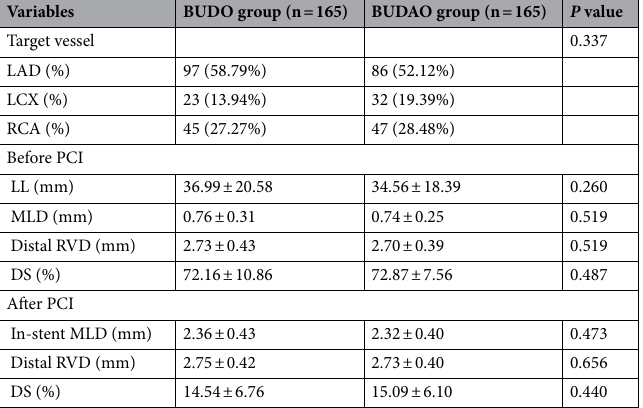
Table 2. Coronary angiography results before and after PCI in the BUDO and BUDAO groups. Data were expressed as n (%), mean ± SD. PCI Percutaneous coronary intervention; LAD Left anterior descending artery; LCX Left circumflex artery; RCA Right coronary artery; LL Lesion length; MLD Minimal lumen diameter; RVD Reference vessel diameter; DS Diameter